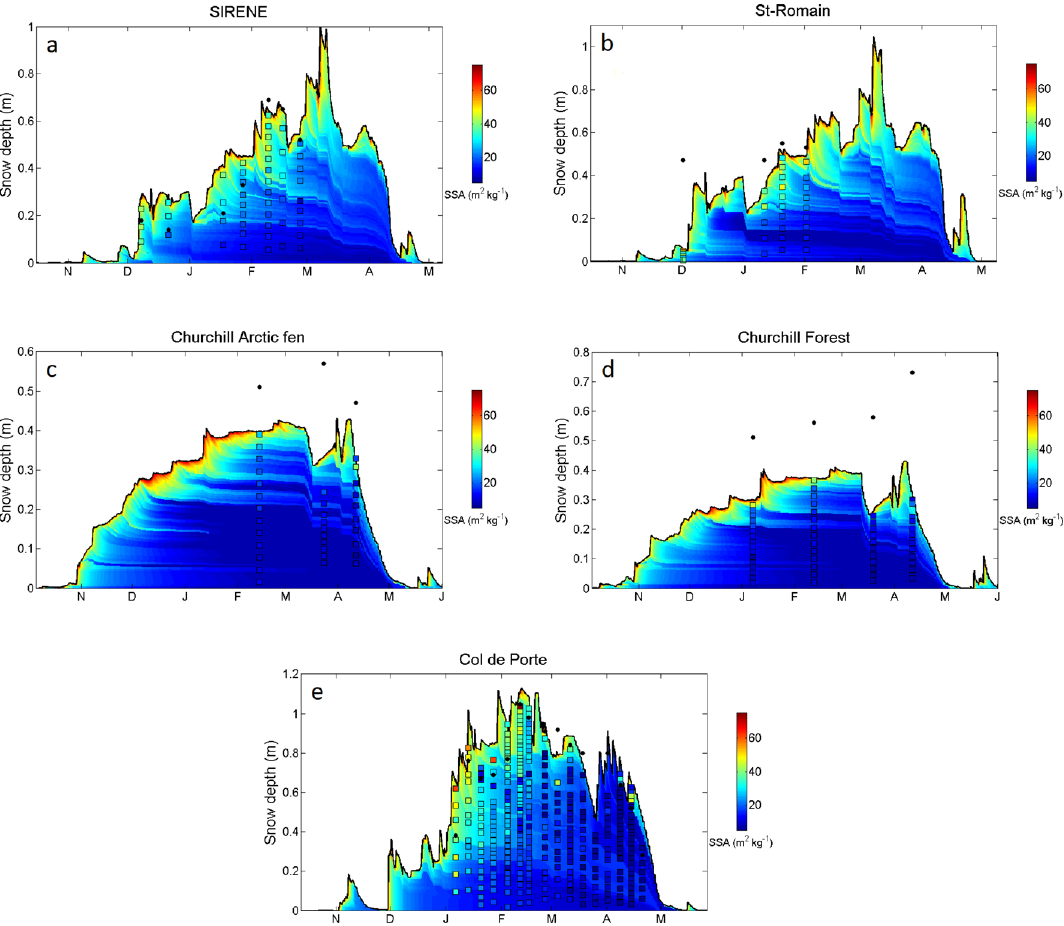
Fig. 6. Seasonal profile of simulated SSA at the five sites, (a) SIRENE, (b) St-Romain, (c) Churchill Arctic fen, (d) Churchill Forest, and (e) Col de Porte), compared to SSA measurements (squares: where the measured SSA profiles were adjusted to the simulated snow depth, see text). The measured profiles are stretched or compressed to fit with simulated snow depth. Black dots correspond to the measured snow